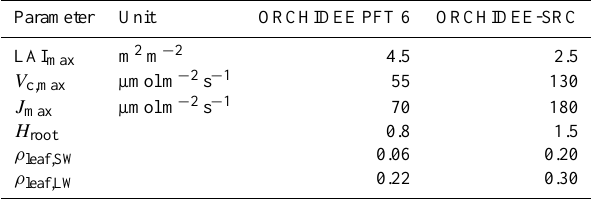
Table 2. Parameter values that were changed between the standard version of ORCHIDEE-FM and the adapted version for SRC sim- ulation. PFT indicates plant functional type, LAI max the maximal leaf area index, V c,max the maximum rate of carboxylation, J max the maximum electron transport rate, H root the exponential decay fac- tor of the root profile, ρ leaf,SW the short-wave leaf albedo, ρ leaf,LW the long-wave leaf